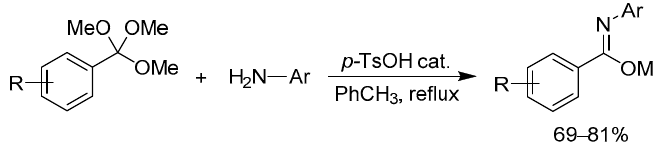
Scheme 10. Possible mechanism for the Rh-catalyzed annulative coupling of methyl